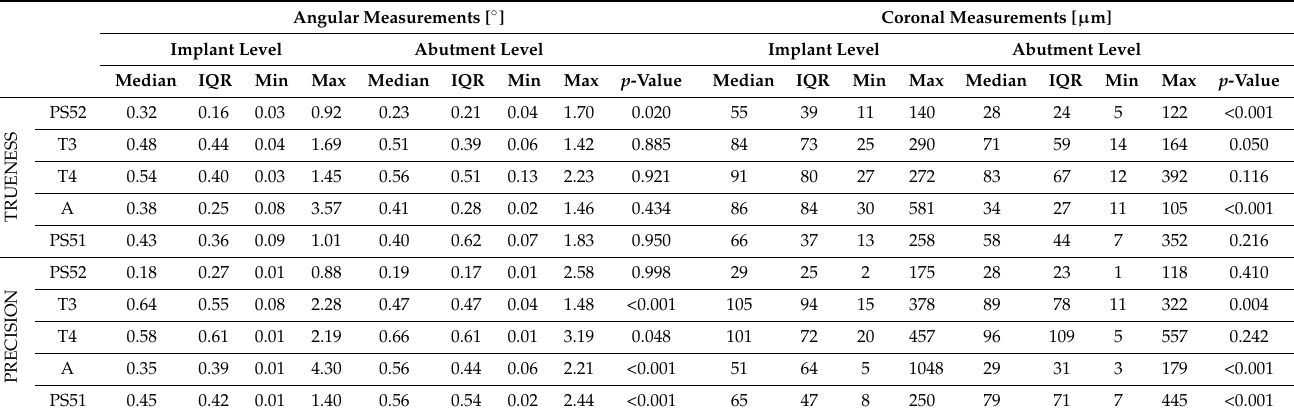
Table 1. All descriptives for trueness and precision for both types of connection with p -values for the Mann–Whitney